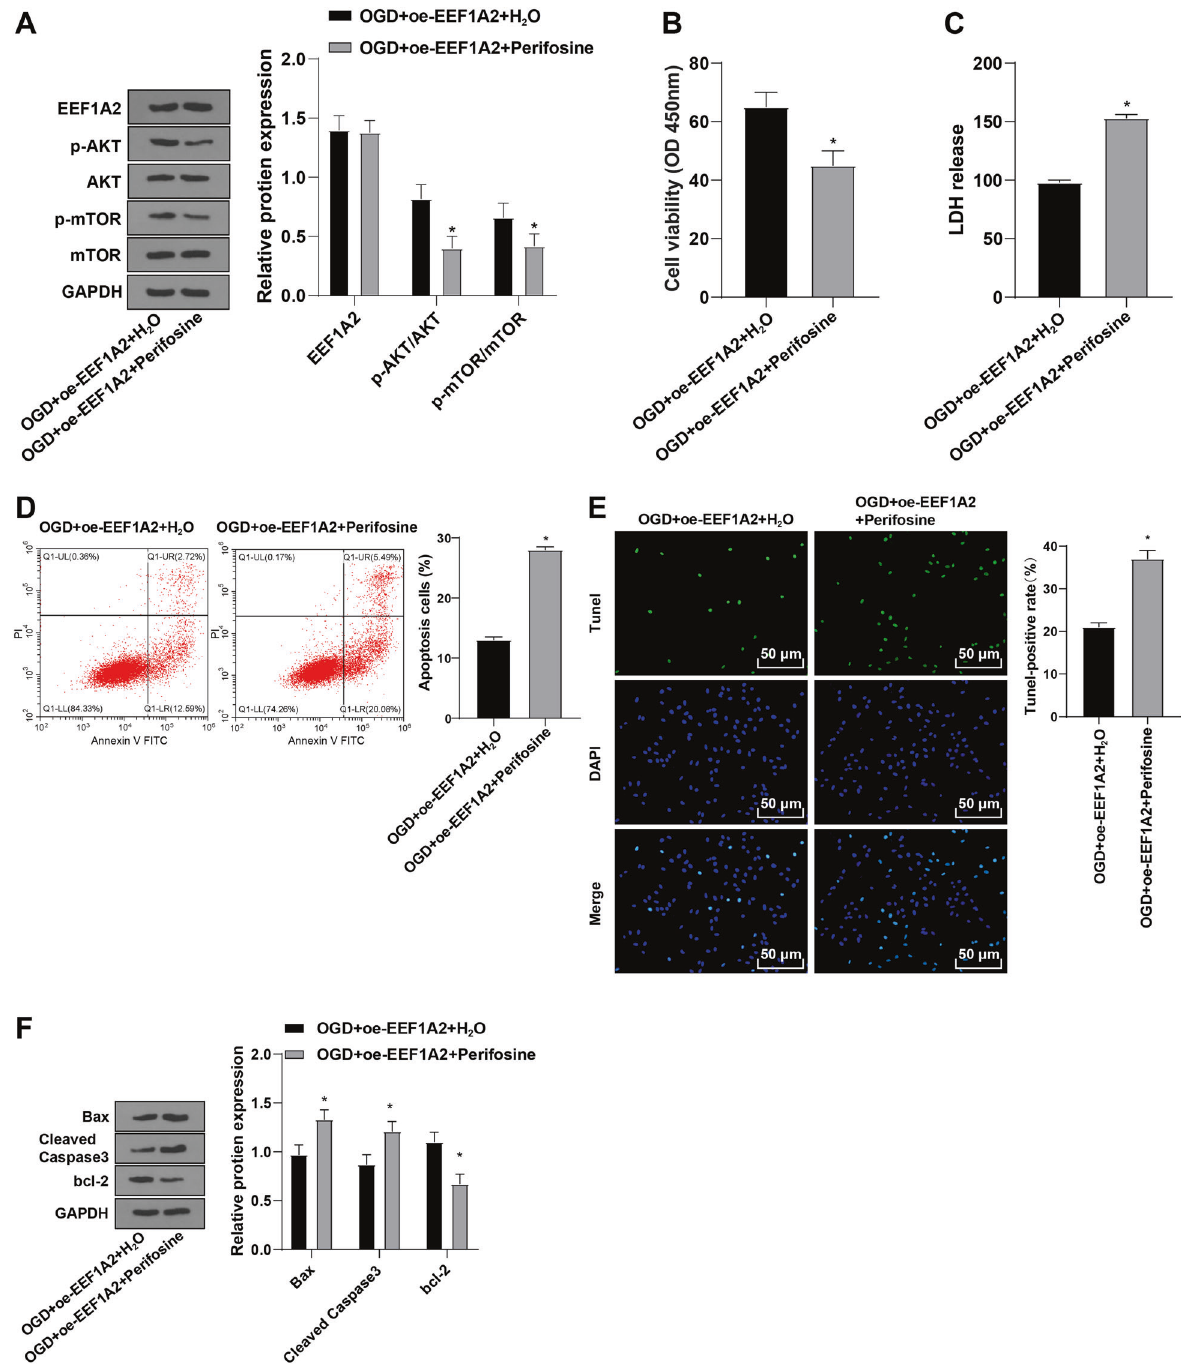
Fig. 7 EEF1A2 promoted viability and inhibited apoptosis of spinal cord neurons by activating Akt/mTOR pathway. A expressions of EEF1A2 and Akt/mTOR pathway-related proteins detected by Western blot; ( B ) neuronal viability detected by CCK-8; ( C ) cell toxicity assessed by LDH release assay; ( D ) neuronal apoptosis detected by fl ow cytometry; ( E ) neuronal apoptosis detected by TUNEL staining; ( F ) expressions of Bax, cleaved caspase3 and bcl-2 detected by Western blot. Data were expressed as mean ± SD and analyzed using independent t test. The experiment was repeated three times. * vs OGD + oe-EEF1A2 + H2O group, p <